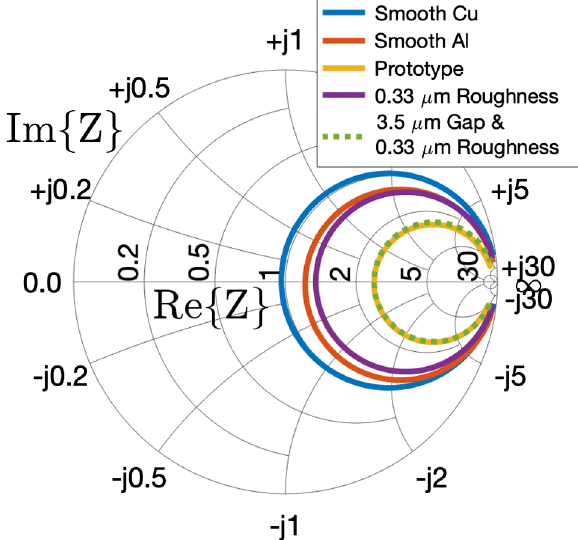
rectangles.FIG. 12. Smith chart showing the variation in simulation output and experimental measurements of S 11 in the range f 0 (cid:2) 1